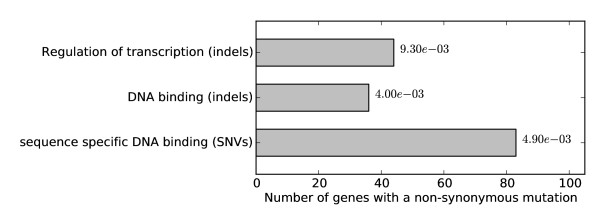
Enrichment analysis of non-synonymous SNVs (n = 1406) and indels (n = 297) performed on the Gene Ontology Fat subset and their Bonferroni corrected p-values are shown. All significantly enriched GO terms are shown (α = 0.05).